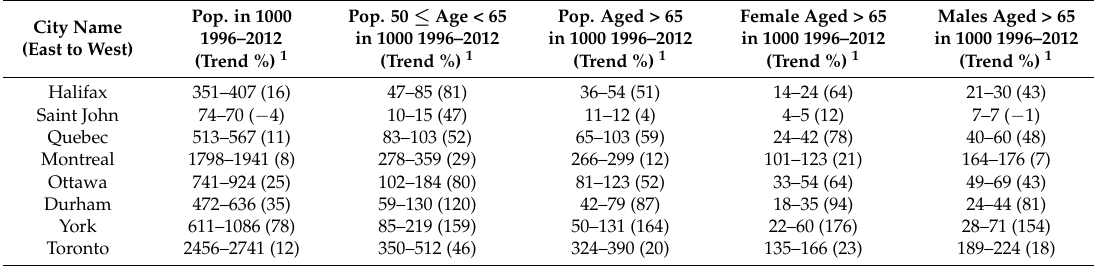
Table 1. Demographic statistics for 24 Census Divisions.